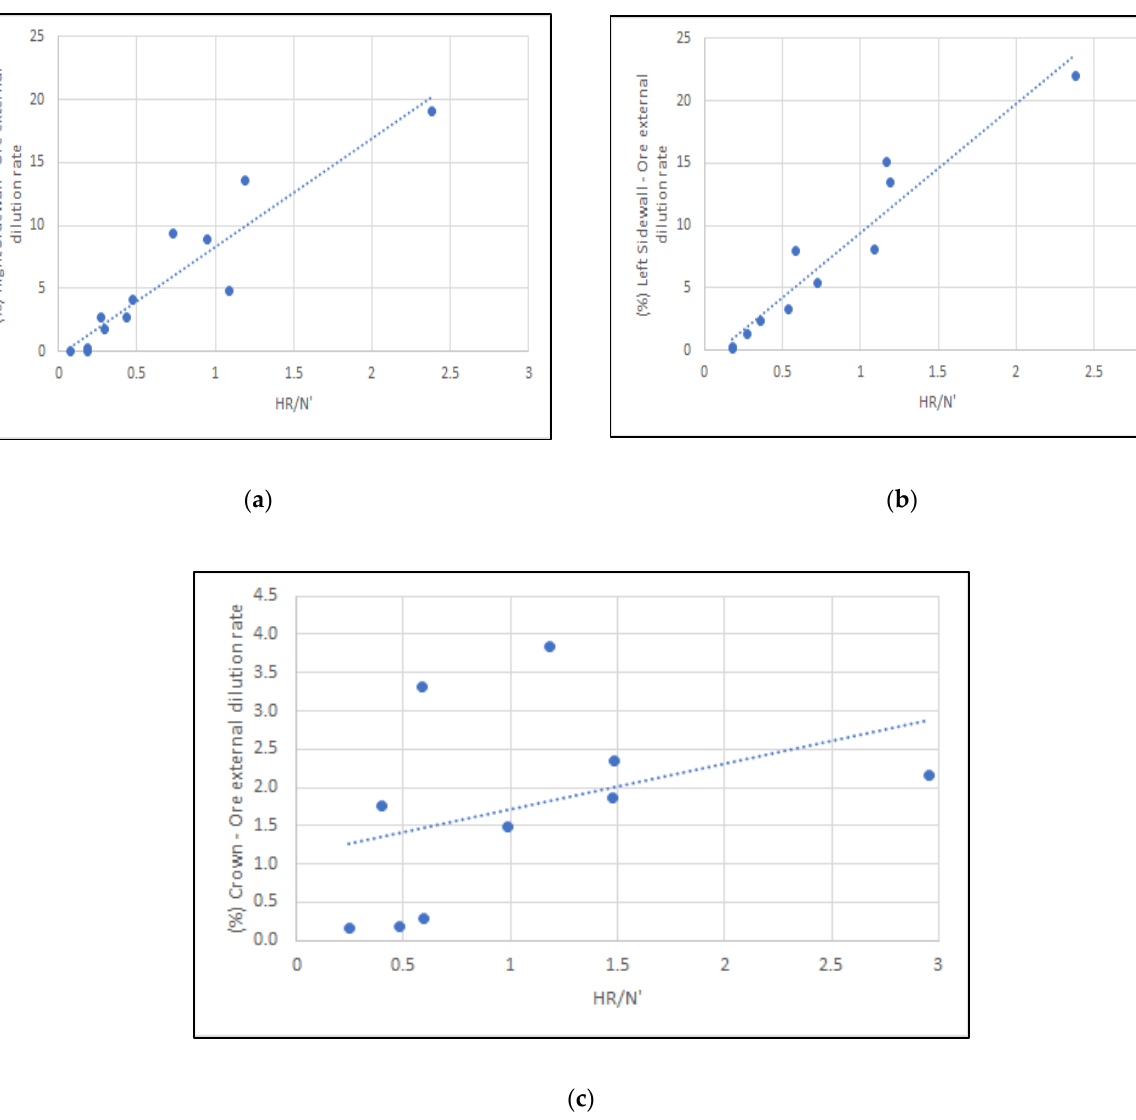
Figure 8. Diagrams of the ore’s external dilution rate vs. HR/N’: ( a ) Right Sidewall (HW) ( b ) Left Sidewall (FW) ( c ) Crown .